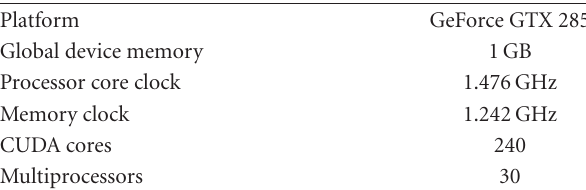
Table 1: Computational capabilities of GPU